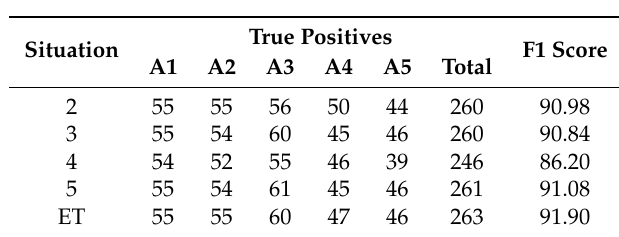
Table 14. Score balance decision.